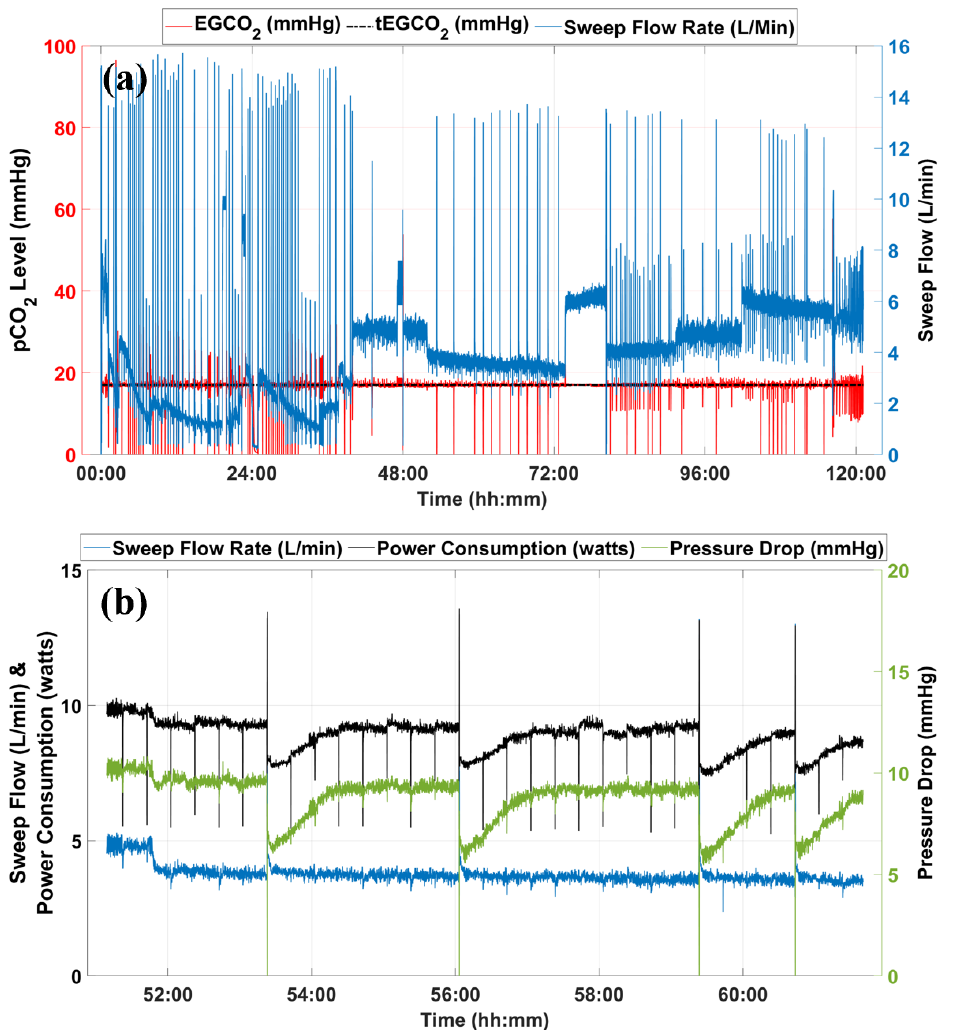
Figure 8. ( a ) Data from long-term in vitro testing using an old AL with water at the flow rate of 1.25 L/min. ( b ) Snippet showing sweep flow rate, system power consumption, and pressure drop across the AL for system operation between 51:00 to 61:00